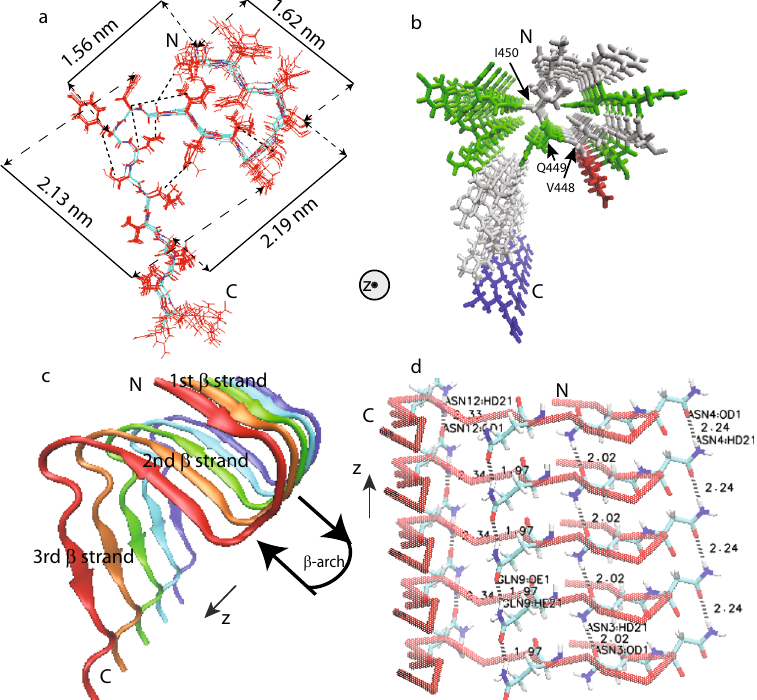
Fig. 6 Structural model of mouse RIPK3 fi bril core (PDB ID 6JPD). a Superposition of ten monomer conformations with the lowest energy, calculated using XPLOR-NIH software. The dimension of the structure is labeled on the sides. The unambiguous constraints used in the calculation are also marked using the dashed lines. b Stick representation of the mouse RIPK3 fi bril medoid model selected from 10 fi bril structures with the lowest energy. Both ( a , b ) are viewed down the fi bril axes. c Side view of medoid model using cartoon representation. d Side view of medoid model indicating possible hydrogen bonding between sides chains of N443, N444, Q449, and N452 (The labels in the fi gure are ASN3, ASN4, GLN9, and ASN12). All fi gures were prepared using VMD (https://www.ks.uiuc.edu/Research/vmd/) 49 .